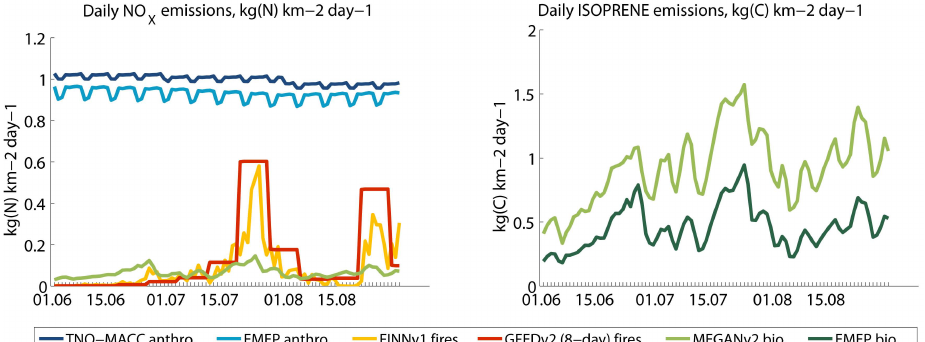
Fig. 3. Temporal evolution of NO x emissions from various sources (left; kg(N)km − 2 day − 1 ) , and of isoprene from biogenic sources (right; kg(C)km − 2 day − 1 ) averaged over the region marked by the dashed rectangle in Fig. 2. Biogenic soil emissions of NO are not included in the EMEP